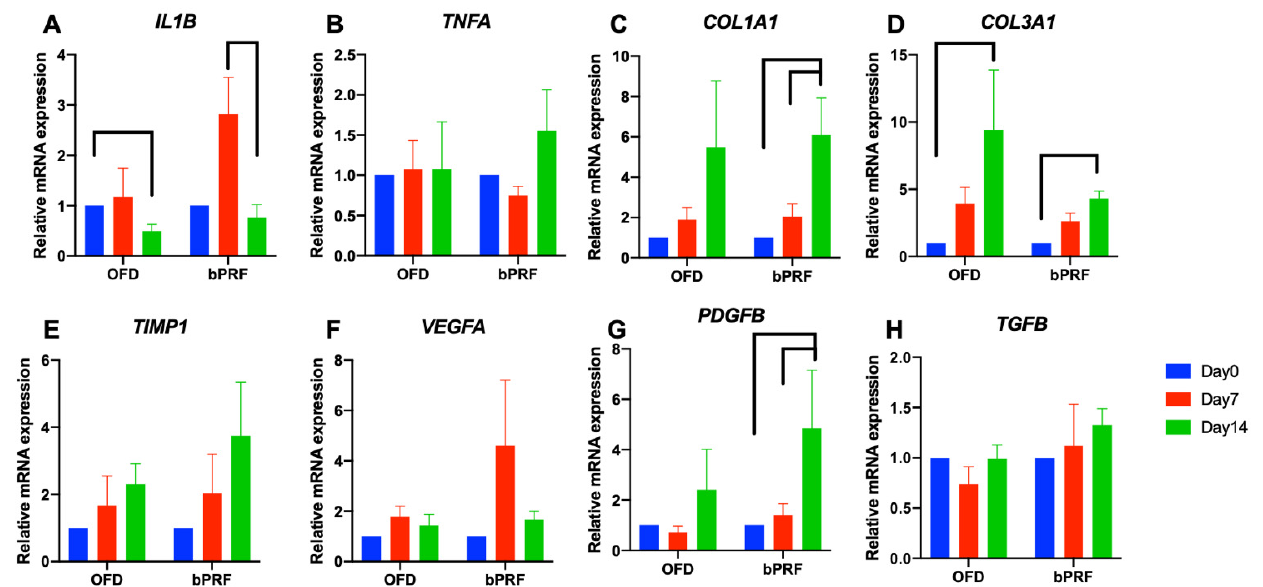
Figure 5. Gene expression analysis of gingival tissues from bubaline blood-derived platelet-rich fibrin (bPRF). Gingival tissues were collected from buccal site of the tooth at days 0, 7, and 14 after intervention. Total RNA was extracted, and the mRNA expression levels were examined using real-time polymerase chain reaction ( A – H ). OFD; open-flap debridement-treated group, OFD+bPRF; open-flap debridement and bubaline blood-derived platelet-rich fibrin-treated group. Bars indicate a statistically significant difference.